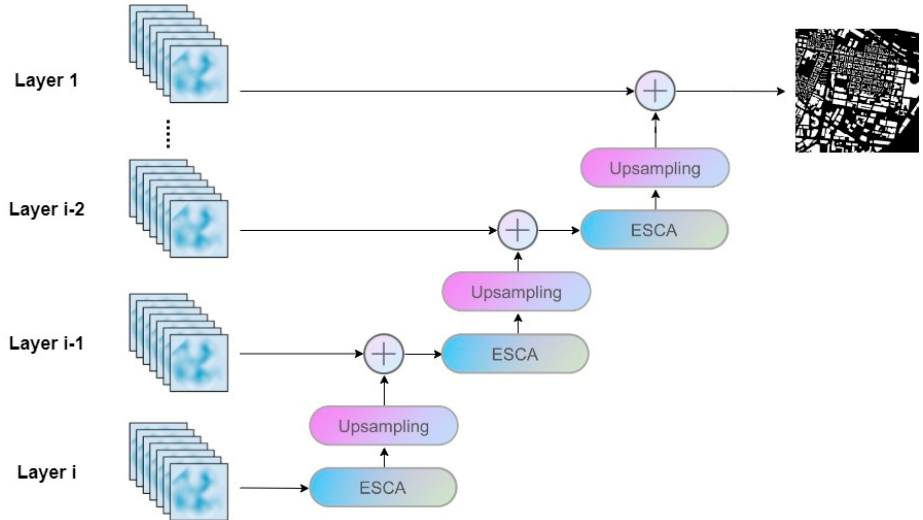
Figure 6. Framework of the MAFA block. Instead of using the traditional bilinear upsampling method to achieve the aggregation of adjacent levels, our MAFA block combines the ESCA mechanism with bilinear upsampling to boost the semantic reconstruction ability of feature maps. Based on the MAFA block, the algorithm utilizes the spatial and channel correlations of segmentation markers, allowing it to more accurately restore the semantic predictions at the pixel level.